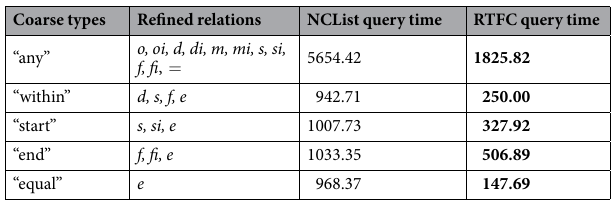
Table 7. The coarse interval query types in “ findOverlaps ” function and the corresponding refined relations in Allen’s interval algebra. Column “NCList query time” indicates the query time (in seconds) using “findOverlaps” function with gnomAD intervals as query intervals and ENCODE intervals as data intervals. Column “RTFC query time” indicates the query time to execute all the corresponding interval queries with respect to the refined relations using RTFC.